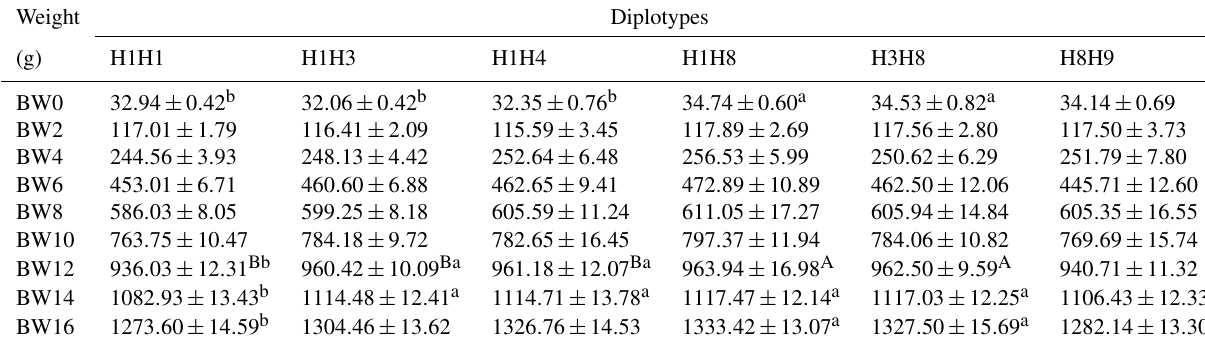
Figure 3. The linkage disequilibrium coefficient D (cid:48) and r 2 map for the Fbxl5 gene in Jinghai Yellow chicken. Table 3. Parameter estimates of Fbxl5 gene different genotypes on body weight traits (means ± SD). Weight